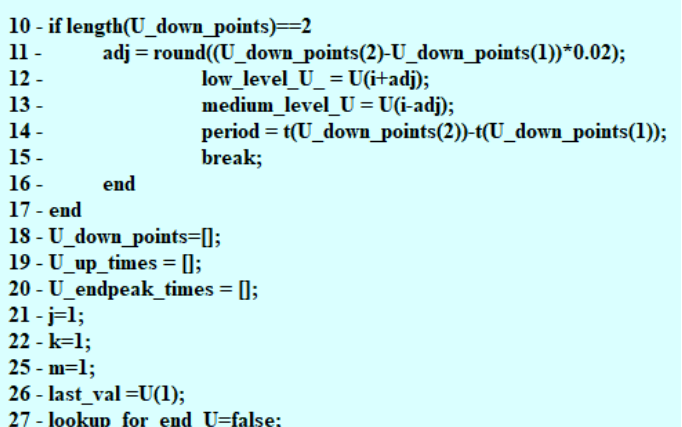
Figure 3. Fragments of code related to the maximal value of the electric voltage.